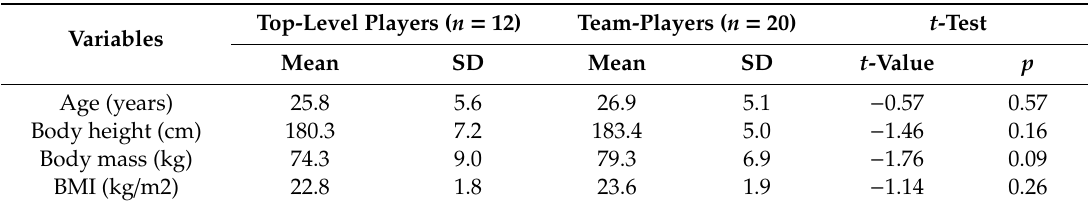
The demographic and anthropometric data of the futsal players included in two performance-groups.